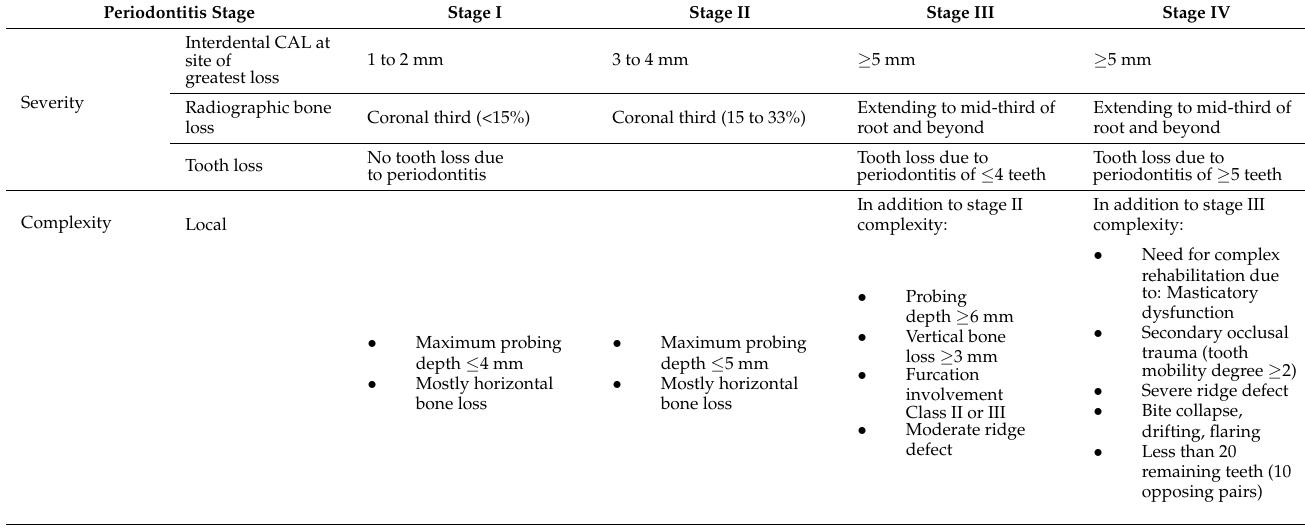
Table 1. Classification of periodontitis based on stages defined by severity, complexity, and extent and